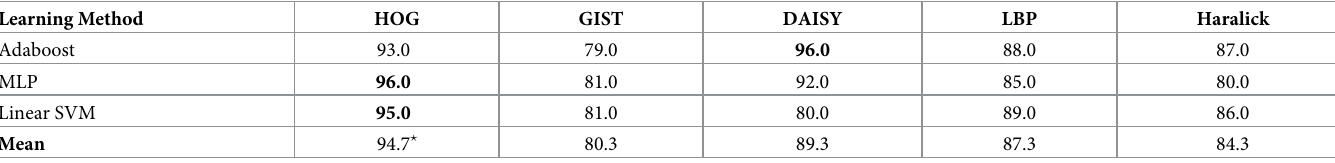
Table 1. Mean accuracies of the classifiers trained with image descriptor features for the stomata classification task. We tested DAISY, Oriented Gradient Histogram —HOG, Haralick Texture Features, Local Binary Patterns—LBP and GIST descriptors, combined with support vector machine, multilayer perceptron and Adaboost machine learning